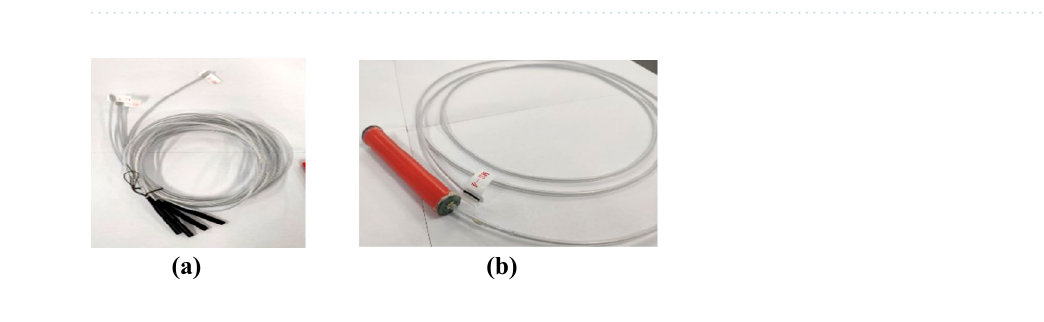
Figure 6. Ultrasonic wave velocity testing system used in this study.